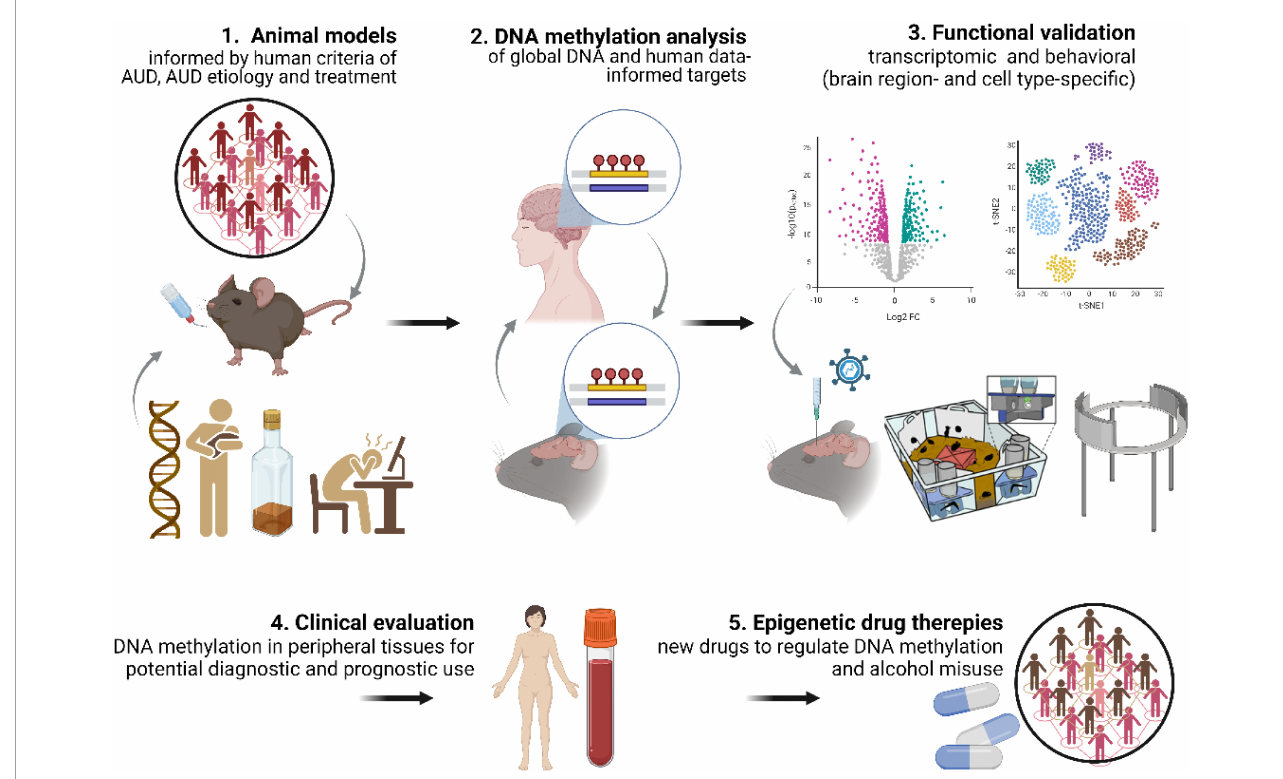
FIGURE3 DNA methylation discovery pipeline. Key aspects needed to increase contribution of DNA methylation studies to understanding AUD mechanisms include: (1) use of advanced, multidimensional animal models of AUD; (2) DNA methylation analyses in animal models informed by human data (and vice versa ); (3) functional validation of DNA methylation both at the transcriptomic and behavioral levels. This approach will allow for (4) identification of DNA methylation markers with diagnostic and prognostic potential and (5) development of epigenetic drug